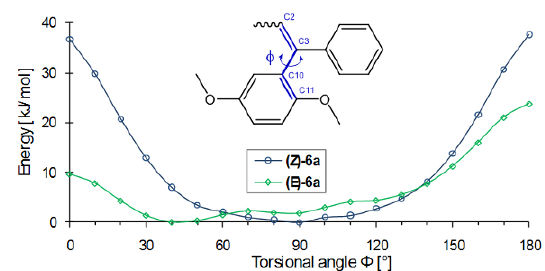
Figure 4. Calculated potential curves for rotation around the C2-C3-C10-C11 torsion angle ( Φ ) for both diastereomers of 6a using the AM1